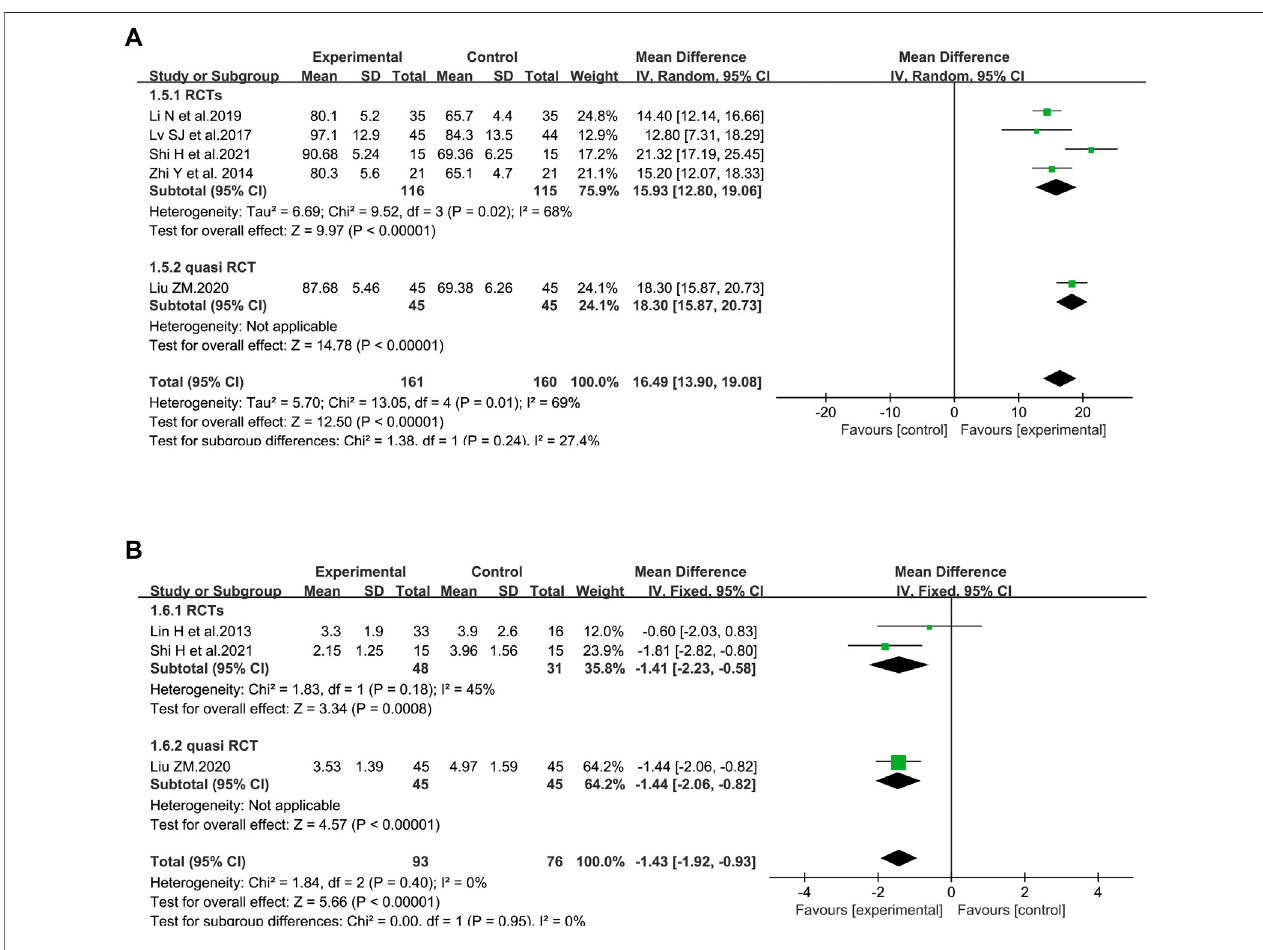
FIGURE 4 | Meta-analysis results of gas exchange based on: (A) PaO 2 ; (B) lactic acid accumulation.